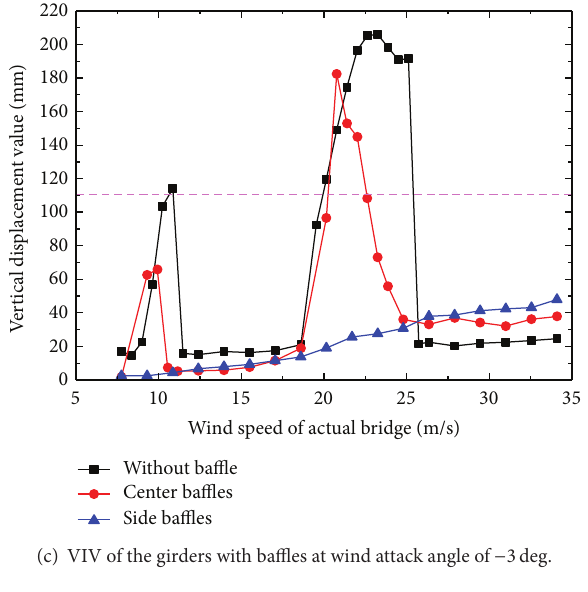
Figure 9: VIV of the girders with